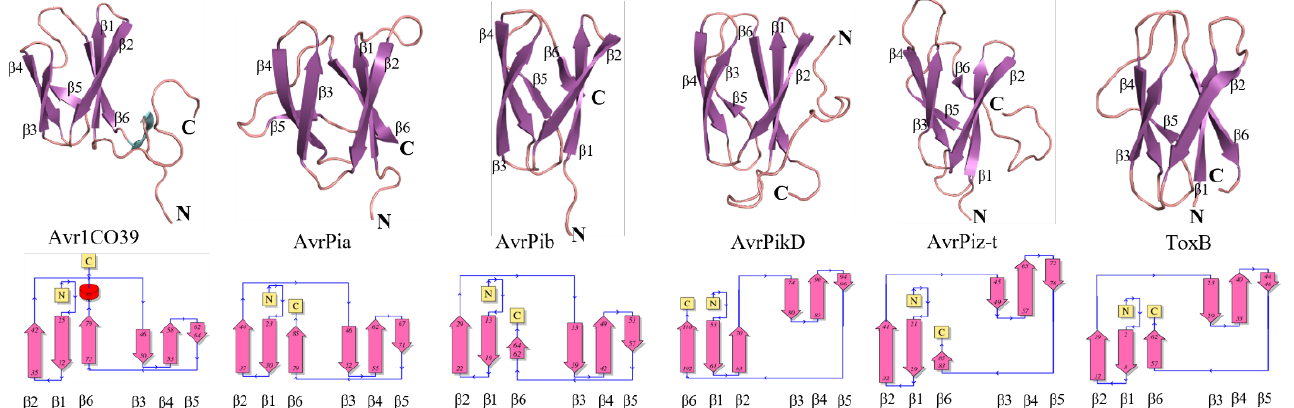
Figure 2. Structures of effector proteins from the MAX family: Avr1CO39 (PDB ID: 5ZNG), AvrPia (PDB ID: 2N37), AvrPib (PDB ID: 5Z1V), AvrPikD (PDB ID: 6FUB), AvrPiz-t (PDB ID: 2LW6) and ToxB (PDB ID: 2MM0). The β -strands are shown in purple, and the α -helix is shown in cyan. The structural topology of the secondary structures is shown below each protein.